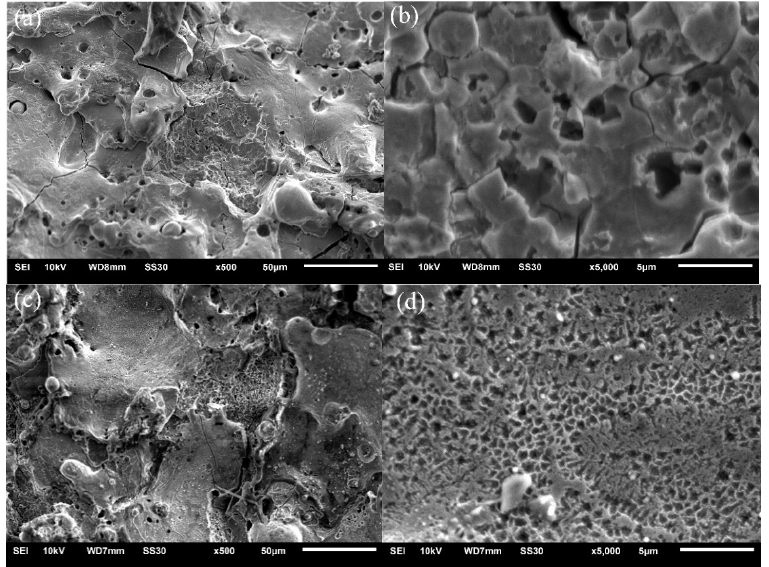
Figure 5. ( a ) Structure of batch 3 after leaching at 60 °C for 2 h. ( b ) Surface pores of the sample after leaching at 60 °C. ( c ) Structure of batch 3 obtained by leaching at 80 °C for 2 h. ( d ) Surface pores of the sample after leaching at 80 °C. the sample after leaching at 80 ◦